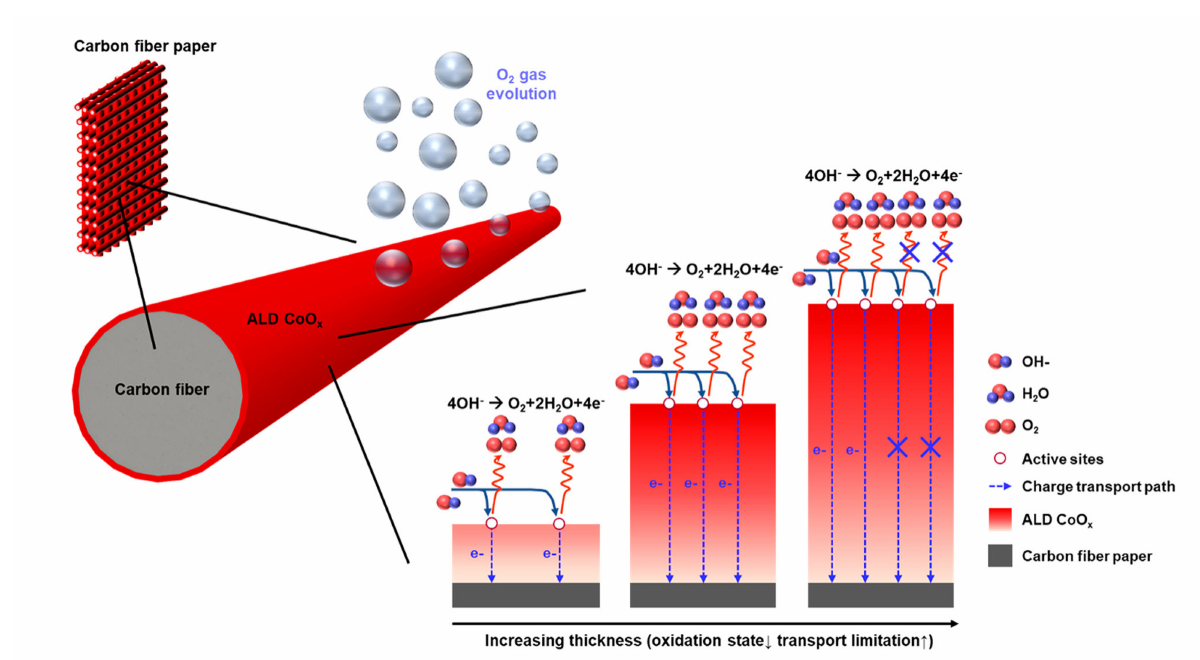
Figure 10. Schematic diagram of the change in oxidation state and charge transport length at various film thicknesses and the consequent OER activity. Reprinted with permission from Choi, H.J.; Han, G.D.; Bae, K.; Shim, J.H. Highly Active Oxygen Evolution on Carbon Fiber Paper Coated with Atomic-Layer-Deposited Cobalt Oxide. ACS Appl. Mater.